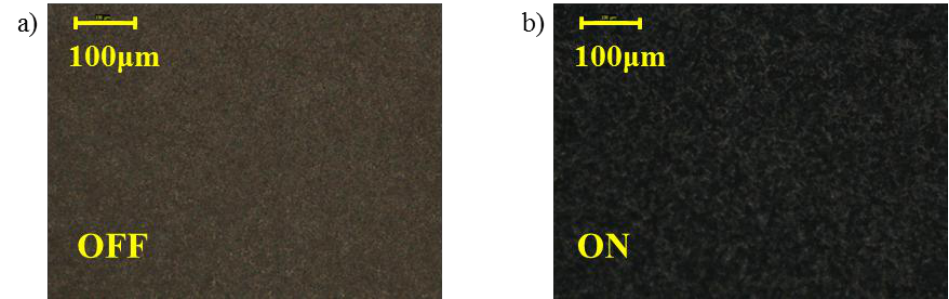
Figure 1. Micro-textures of the droplets morphologies of the polymer dispersed liquid crystals (PDLC) films under cross polarizers at 20× magnification and PDLC devices in the OFF and ON state: ( a ) V = 0 V; ( b ) V = 24 RMS RMS